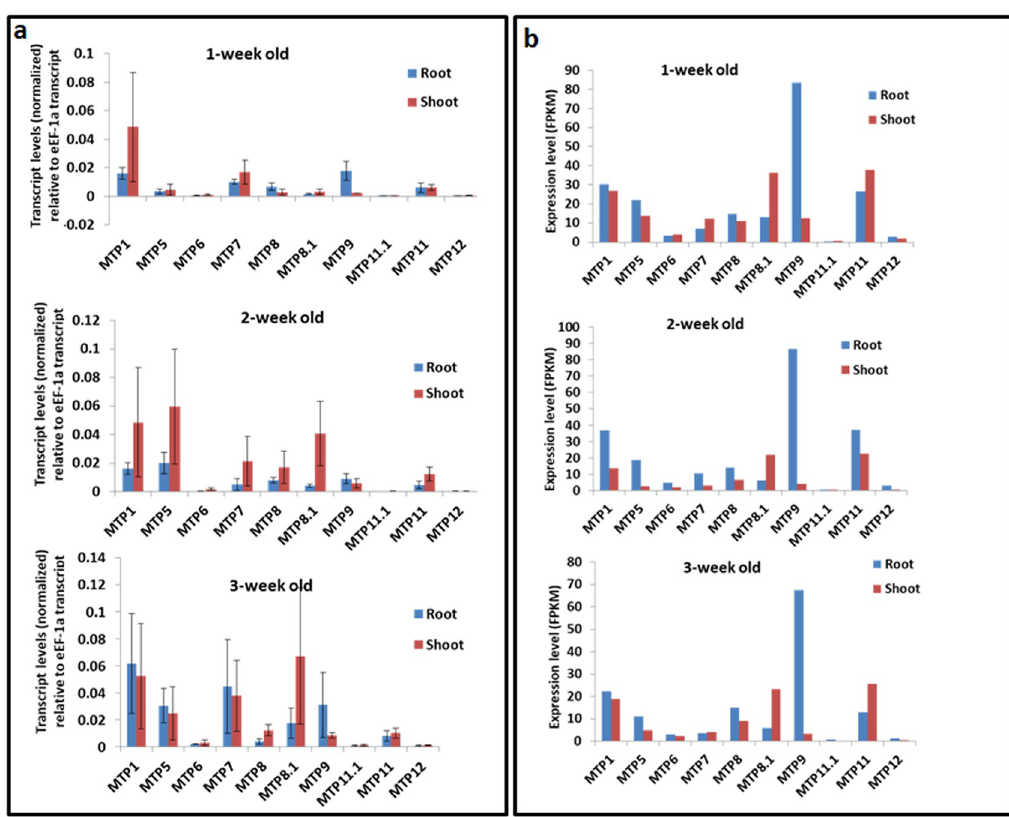
Fig 3. Expression profiling of rice metal tolerance protein (MTP) genes in root and shoot tissues of 1-week, 2-week, 3-week old seedlings. (a) Q-PCR analysis of MTP transcripts. Transcript levels of the MTP genes were normalized with transcript levels of internal reference gene OsUBQ5 . Then the resulting expression level of MTP genes was compared to normalized expression level of constitutively expressed OseEF-1a gene. The resulting levels of expression of MTPs are compared among themselves as well as between roots and shoots. (b) Expression values in FPKM (fragments per kilobases of gene per million mapped reads) obtained from Rice Expression Database